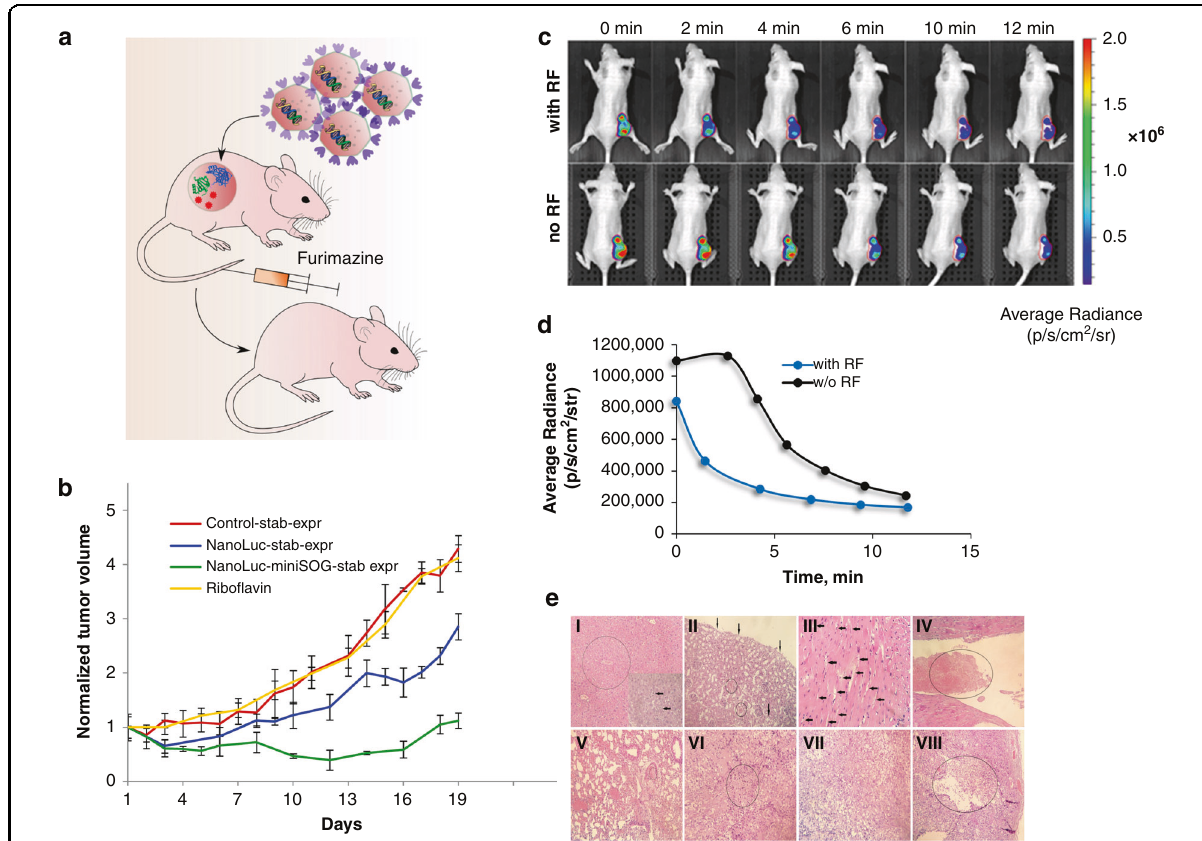
Fig. 2 Assessment of ef fi cacy of NanoLuc-miniSOG system expressed by BT-474 cells in vivo. a Schematic presentation of the experiment. BT- 474 cells stably expressing NanoLuc-miniSOG are inoculated subcutaneously into an animal. Gene expression of NanoLuc-miniSOG leads to production of fusion protein NanoLuc-miniSOG, which leads to BRET-activation of miniSOG after the injection of furimazine, followed by the ROS production and cancer cell kill. b Tumor-growth curves for various treatment conditions: mice bearing BT-474 tumor xenograft, treated with PBS (red curve); BT-474/NanoLuc-expressing tumors treated with furimazine (blue curve); mice bearing NanoLuc-miniSOG-expressing tumors treated with furimazine and ribo fl avin (green curve); mice bearing NanoLuc-miniSOG-expressing tumors treated with ribo fl avin (yellow curve). Data are presented as the mean ± SD ( n = 6). c Evidence of BRET effect in vivo. An image of a living animal imaging after i.v. furimazine administration with (top row) and without (bottom row) Rf pre-injection. The difference in the distribution of average luminescence signals is a sign of BRET in NanoLuc-miniSOG system. The tumor region is indicated as a red-circled area. d Luminescence intensity signal from the tumor region measured in photons per second per cm 2 per steradian with and without RF pre-injection. e Hematoxylin-eosin-stained histological sections of different organs and tumors at the end of furimazine treatment (I-VI) and after completion of the experiment (VII, VIII). I — Liver. In the center of the lobules weakly expressed plethora and hydropic degeneration of hepatocytes are circled, necrosis of individual hepatocytes with small focal leukocyte in fi ltration are pointed with arrows, magni fi cation ×200. II — Kidney with focal hydropic dystrophy of the epithelium of the proximal convoluted tubules (arrows) and small focal hemorrhages (circled), magni fi cation ×200. III — Hydropic dystrophy of cardiomyocytes (arrows), magni fi cation ×400. IV — Heart with a fi brin thrombus (circled) in the lumen of the left ventricle, magni fi cation ×200. V — Lungs with plethora, con fl uent hemorrhages, fi brin thrombus in the lumen of the vessel (circled), magni fi cation ×200. VI — Tumor with a focus of necrosis (circled), magni fi cation ×200. VII — Tumor. Poorly differentiated adenocarcinoma, magni fi cation ×200. VIII — Tumor with necrosis and decay cavity (decay cavity with necrotic masses in the lumen is circled), magni fi cation